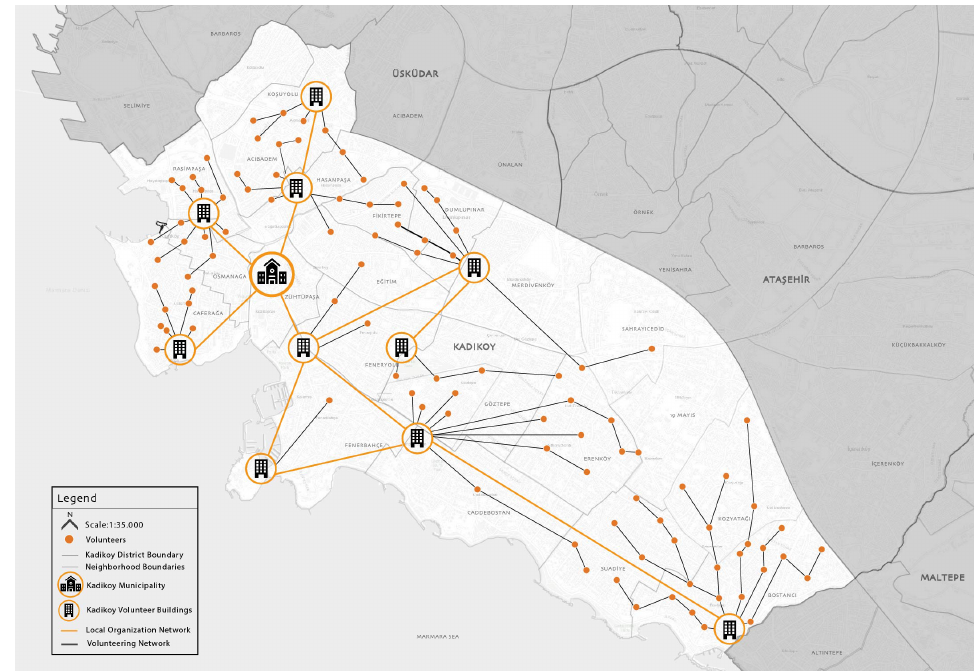
Figure 5. Participants and Volunteering Network of Kadikoy District (map was created by using Survey123 location data of 100 volunteers (via ESRI software) and Volunteer House data